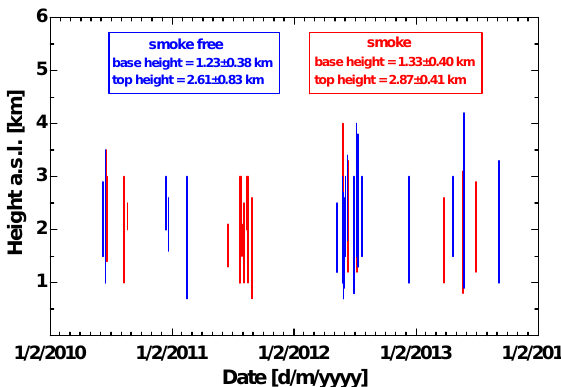
Figure 6. Lofted free-tropospheric aerosol layers (shown as verti- cal lines from bottom to top) observed during northerly air flows between April 2010 and February 2014. In the case of the blue ver- tical lines (21 smoke-free cases) no fire events over Turkey occurred and influenced the lidar measurements. In the case of the red layers (24 fire smoke cases), the air masses crossed fire areas over Turkey before arriving at the lidar site at Limassol. The average bottom and top heights (plus one standard deviation) of all detected layers, sep- arately for smoke and smoke-free cases, are given in